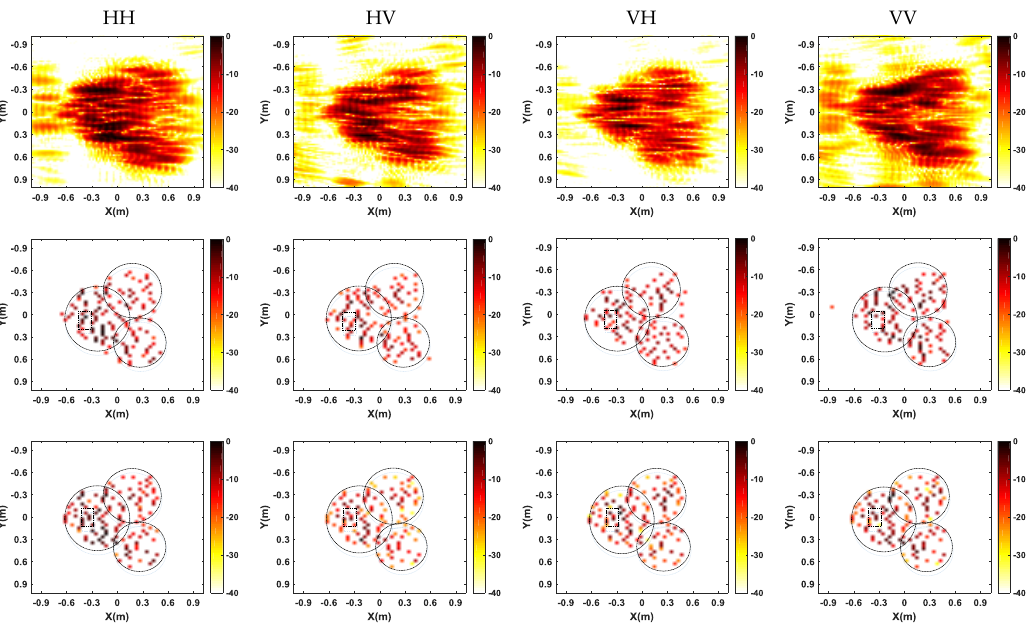
Figure 14. Comparison of imaging results by different imaging methods. Up: traditional filtered back-projection method; Middle: single channel CS method; and down: multichannel joint CS method.